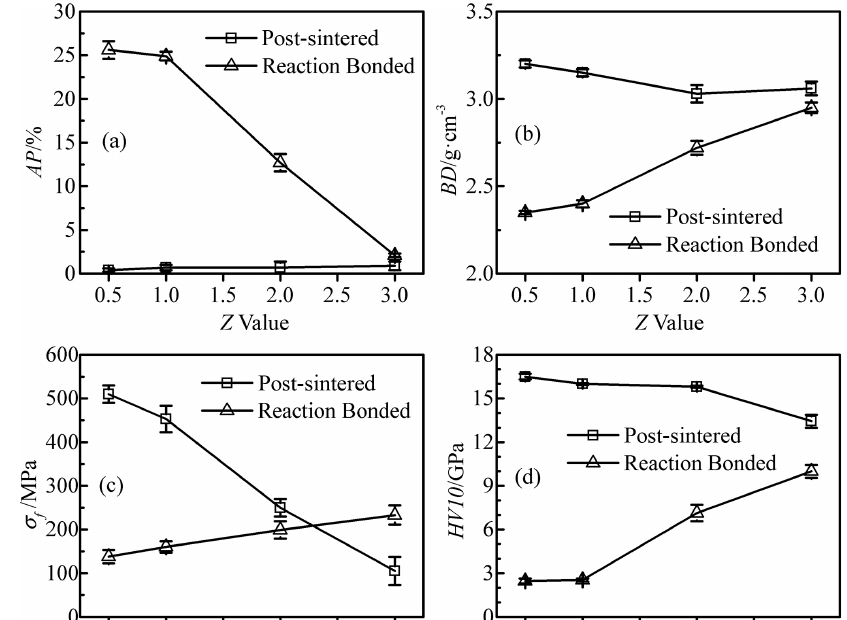
Figure 1: XRD patterns of the fabricated samples, (a) RB- β -SiAlON, (b) PSRB- β -SiAlON.